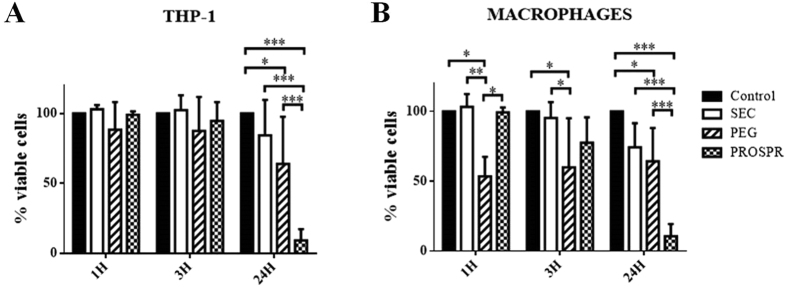
EV effect on cell viability.(A) Viability of THP-1 cells and (B) THP-1-derived macrophages incubated with THP-1-EVs from SEC, PEG or PROSPR isolation. The results are expressed as the percentage of viable cells relative to the control condition (PBS) in each particular experiment. Bars represent mean+/−SD of 3 to 5 independent experiments. Differences with *P < 0.05, **P < 0.005, and ***P < 0.0001 were considered statistically significant by Two-way ANOVA, Tukey test.